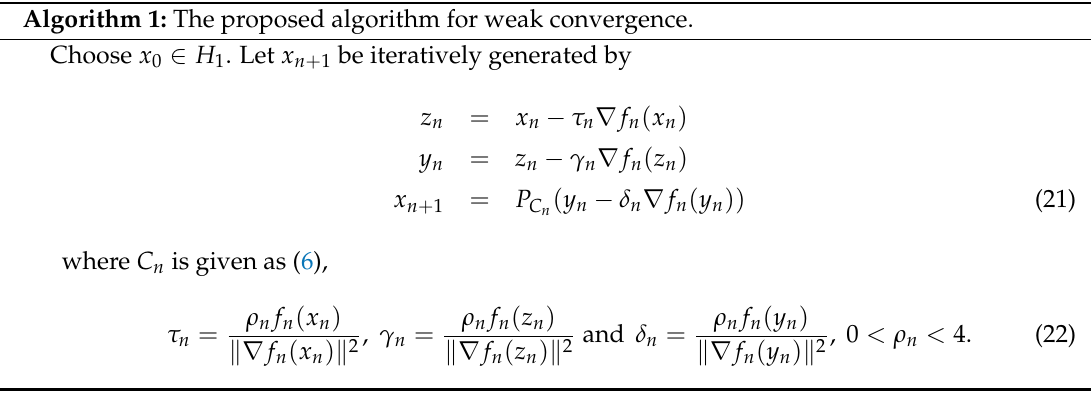
Algorithm 1: The proposed algorithm for weak